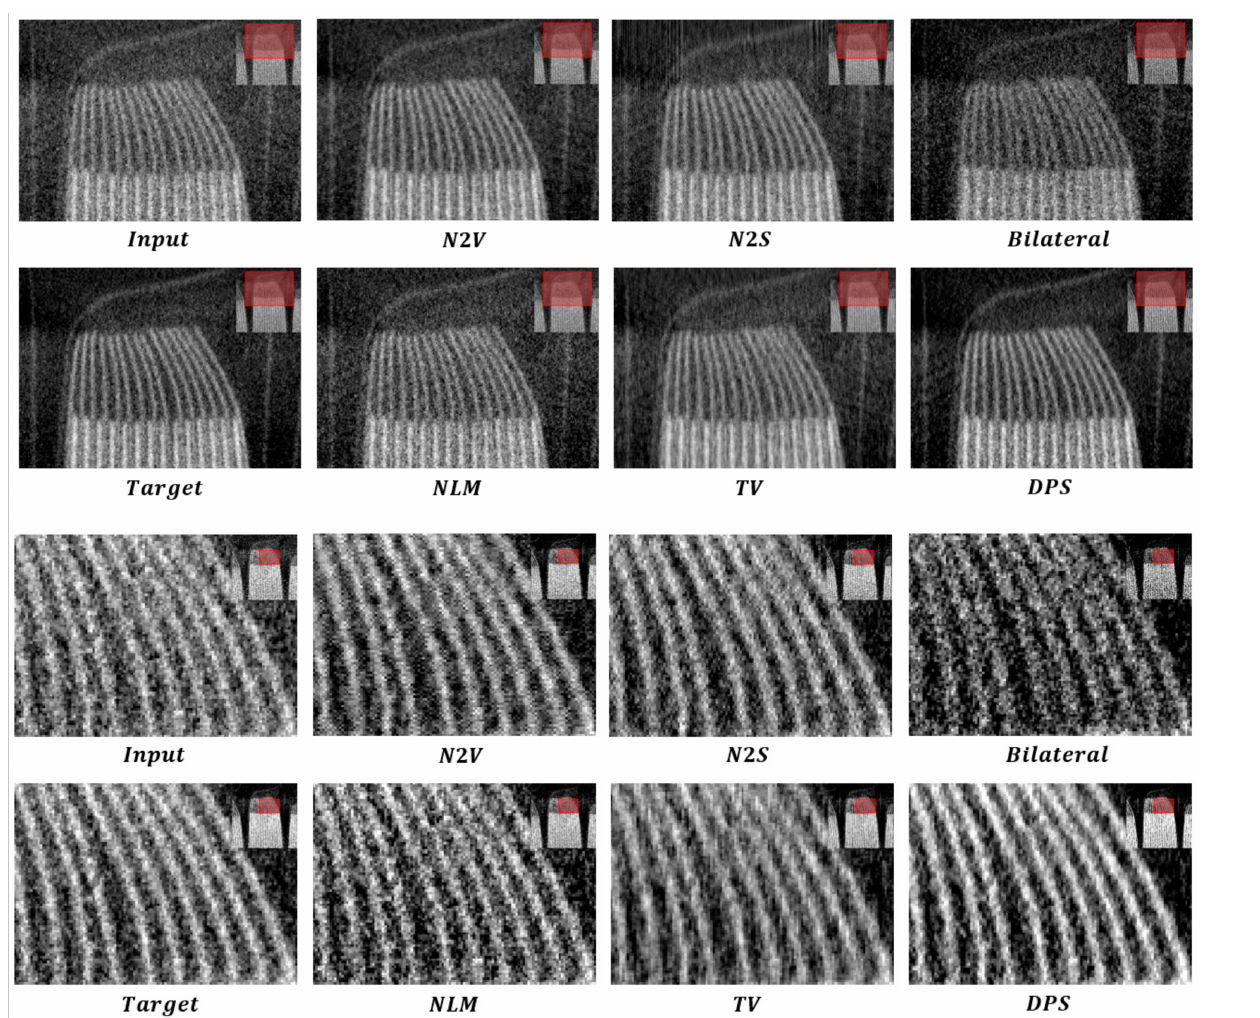
Figure 5. Two visual comparisons of various denoising methods from the lithium polymer battery dataset with an in-house CBCT system: (first and second rows) coarse architecture and (third and fourth rows) fine architecture. All images are in the coronal view. Red boxes in the images indicate the expanded